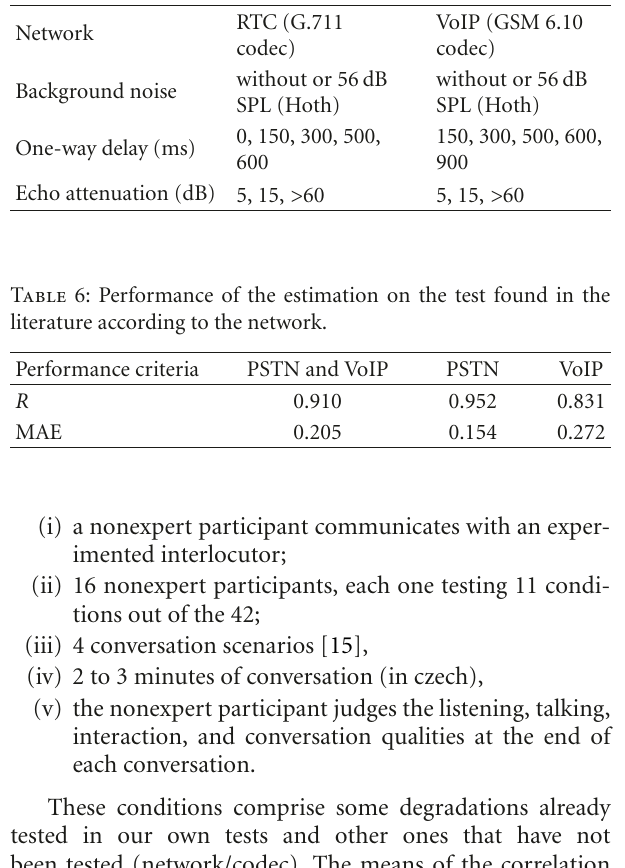
Table 5: Conditions of the test found in the literature [37].